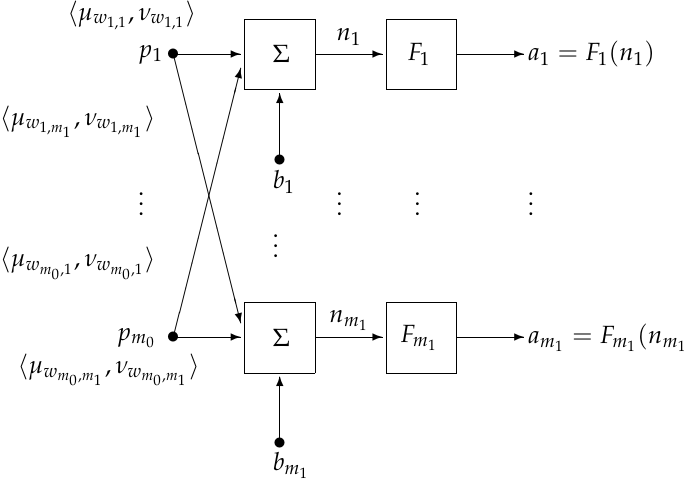
Figure 3. IFNN with one layer and many multi-input neurons.